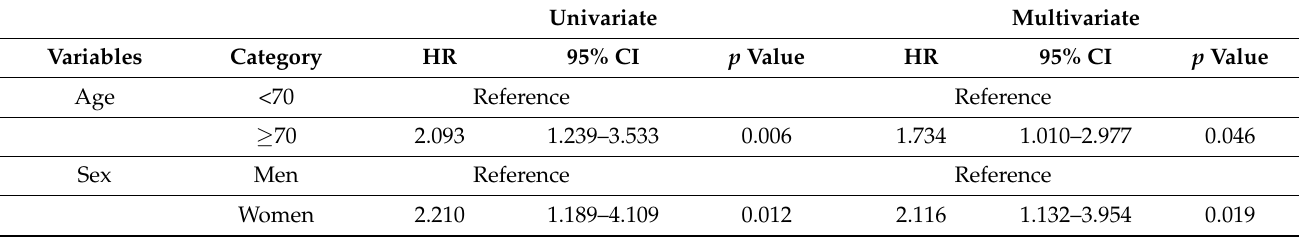
Table 2. Cox proportional hazards analysis of overall survival in patients undergoing radical